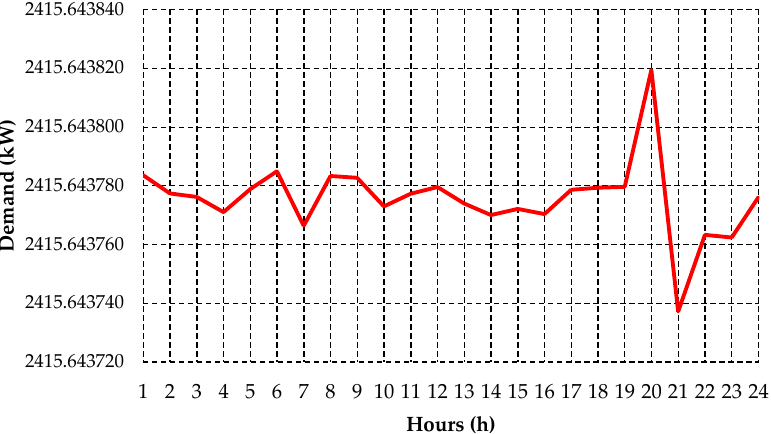
Figure 13. Daily demand profile of irrigator customers resulting from load shifting at the Rural Feeder A. Source: The authors.